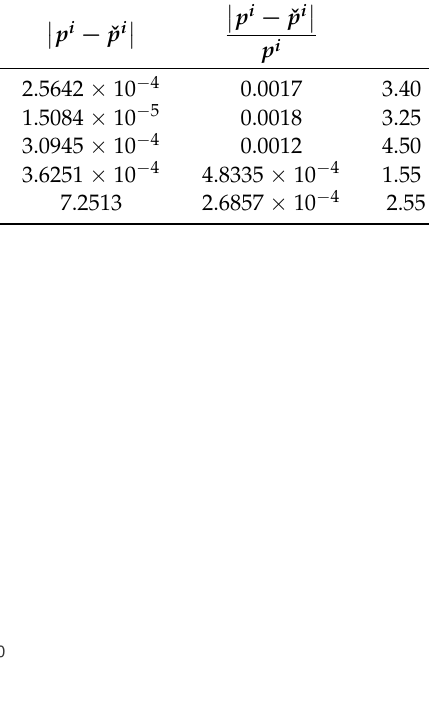
Figure 8. The implied population dynamics with model (3a)–(3c) and perturbed observations with 20%